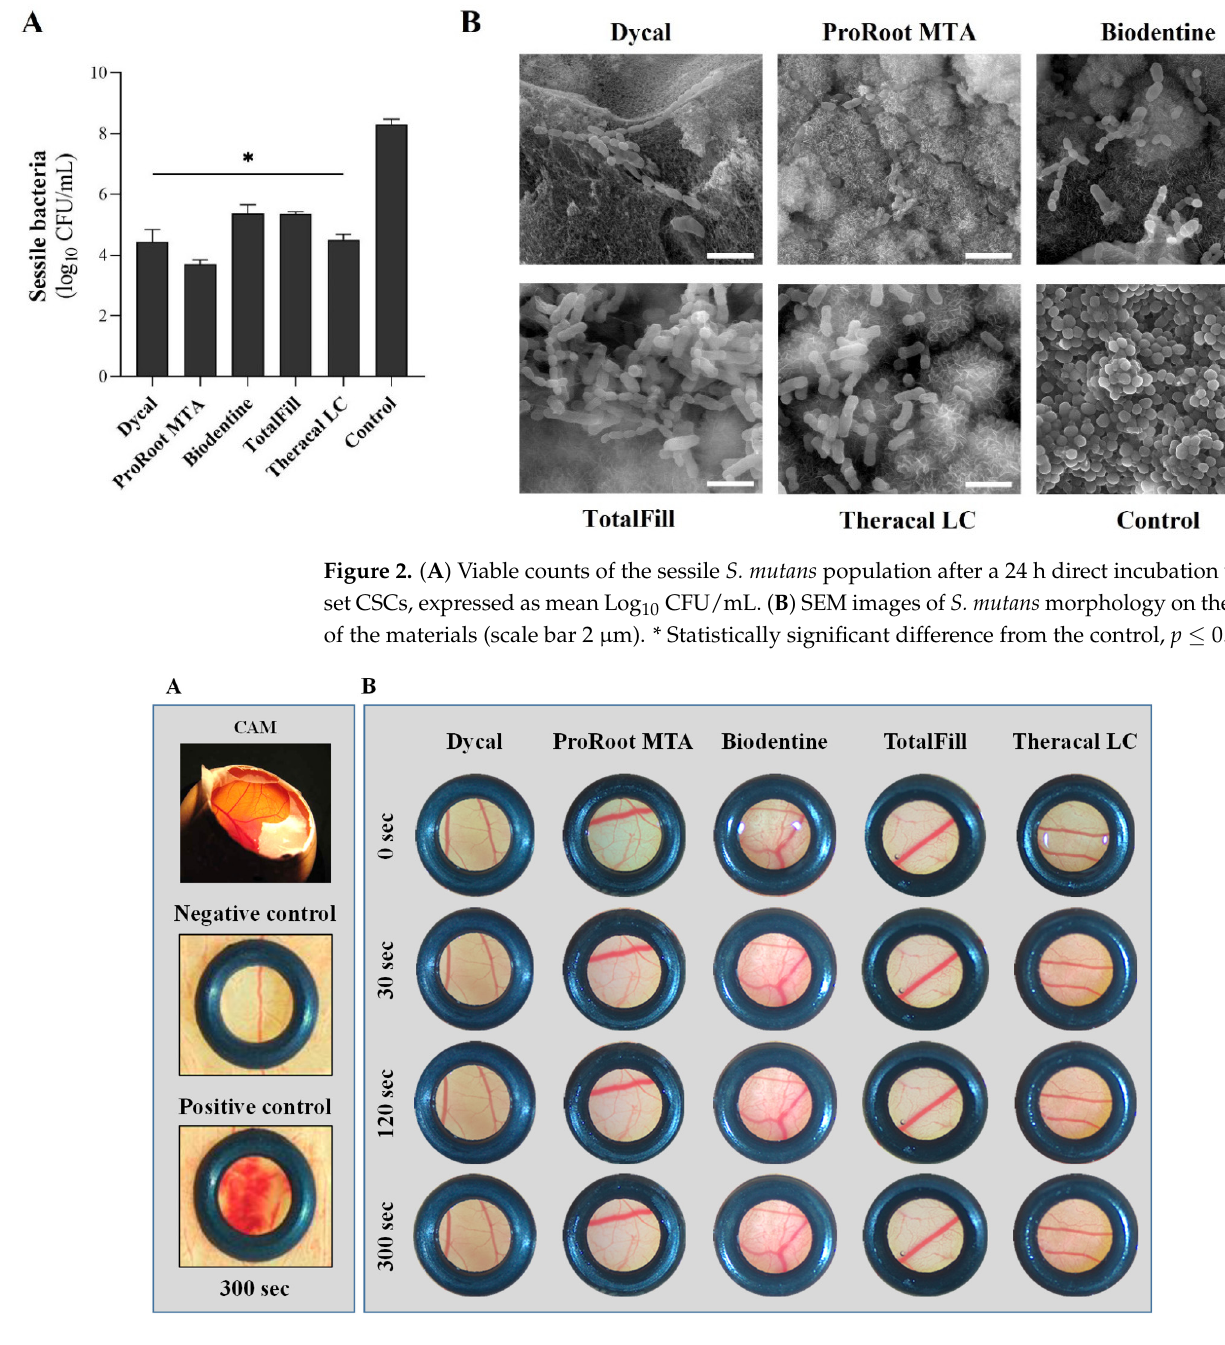
Figure 3. In vivo HET-CAM irritation assay. ( A ) Representative images of CAM and the negative and positive controls after exposures of 300 s. ( B ) Representative CAM images after exposure to the undi- luted cement extracts for periods up to 300 s. Microscopic images were taken at 10 ×